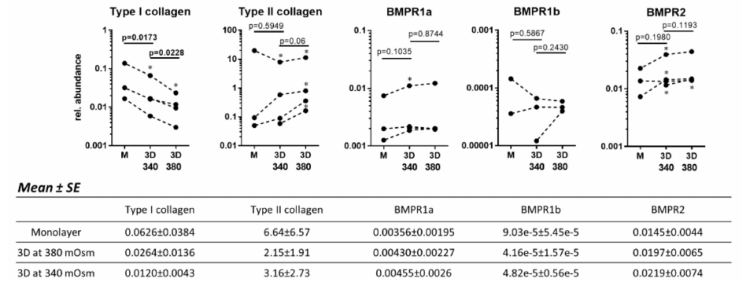
Figure 5. Human OA chondrocytes were cultured in a monolayer (M) for one week followed by three weeks in alginate (3D) at 340 or 380 mOsm. The gene expression of type I and type II collagen as well as of BMPR1a, b and BMPR2 was evaluated by RT-qPCR after the monolayer culture and after the alginate culture for each of the donors. Data on the graphs represent the mean of technical replicates ( n = 3–6). Statistical analysis was performed for each donor separately (*means p < 0.05) and for all donors together with the p values being shown on the graphs ( p values are bold when p ≤ 0.05). The means and standard errors of the mean (SE) for all donors together are tabulated below the